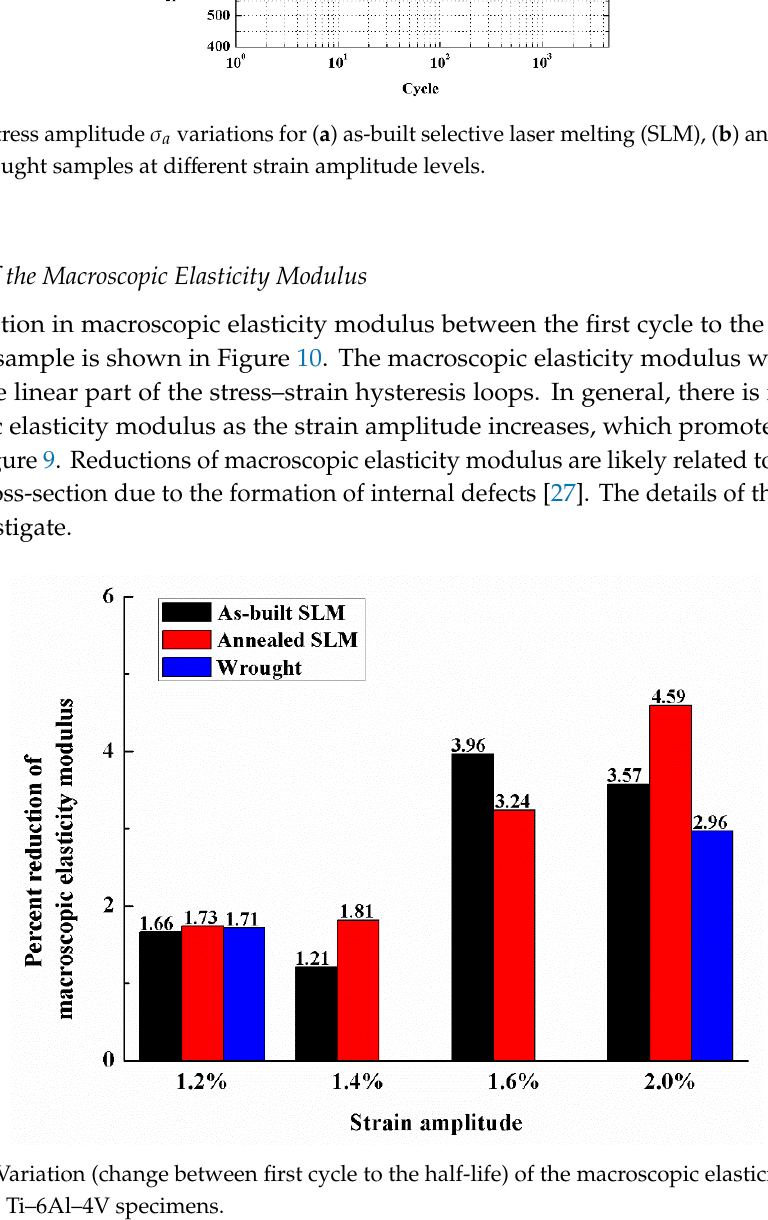
Figure 10. Variation (change between first cycle to the half-life) of the macroscopic elasticity modulus for the LCF Ti–6Al–4V specimens.